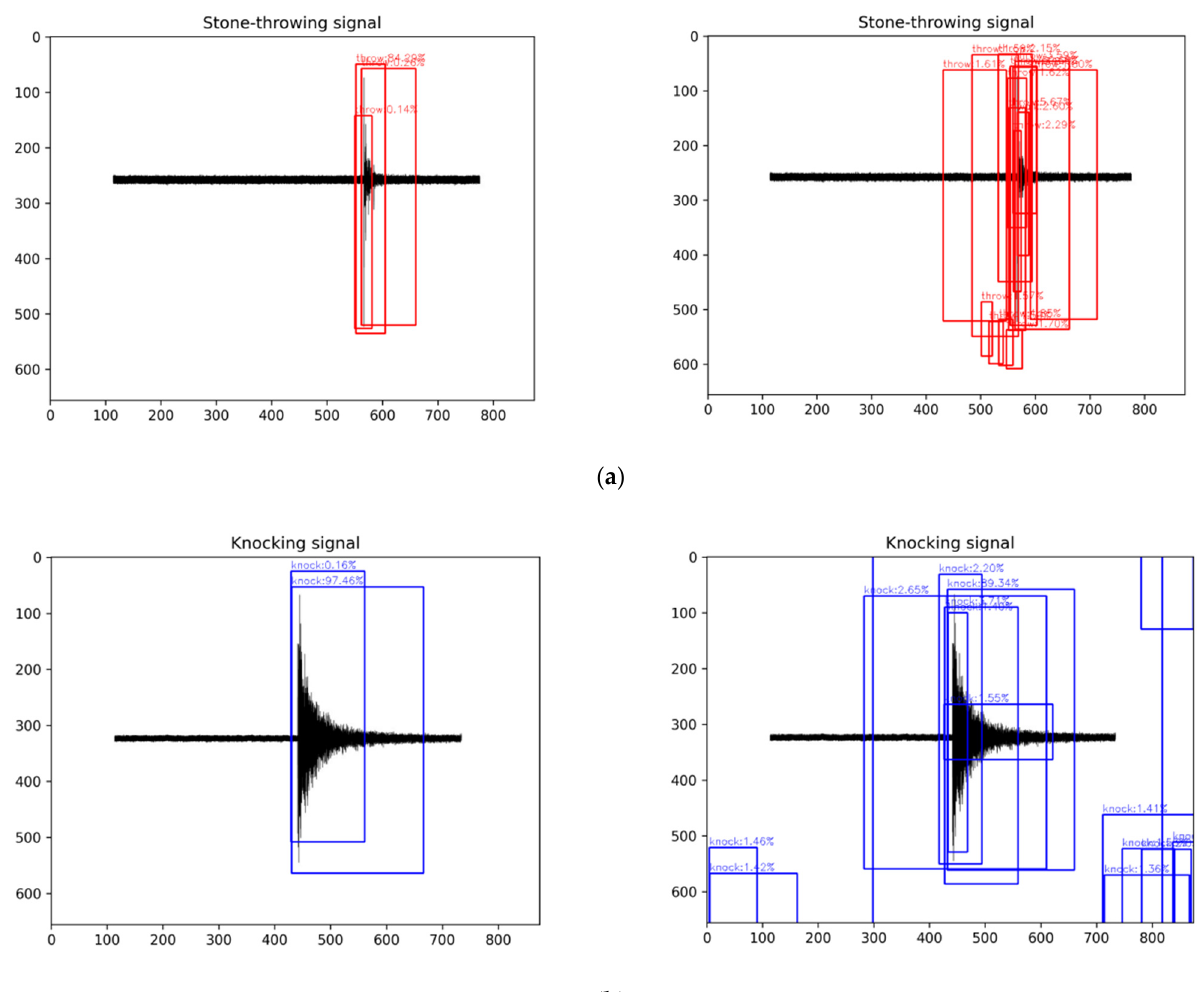
Figure 16. The prediction results of the focal loss function for two types of signals with large differences in sample distribution; ( a ) stone-throwing signal, the left side of the figure is the result predicted by the focal loss function, and the right side is the result predicted by the YOLOv4 confidence loss function; ( b ) the knocking signal and the left and right sides of the figure are the same as ( a ).